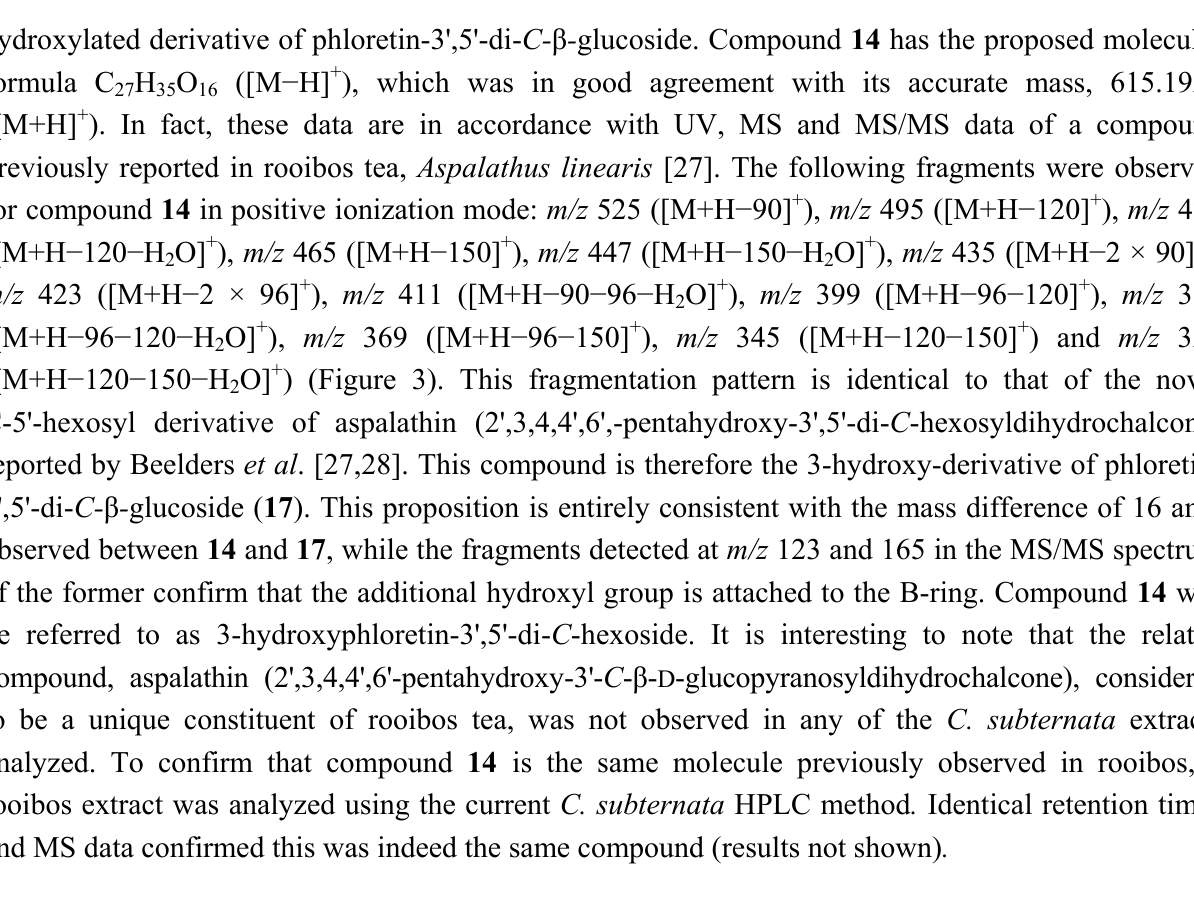
Figure 3. LC - MS/MS spectrum of 3-hydroxyphloretin-3',5'-di- C - β -hexosyl ( 14 ) obtained in positive ionization